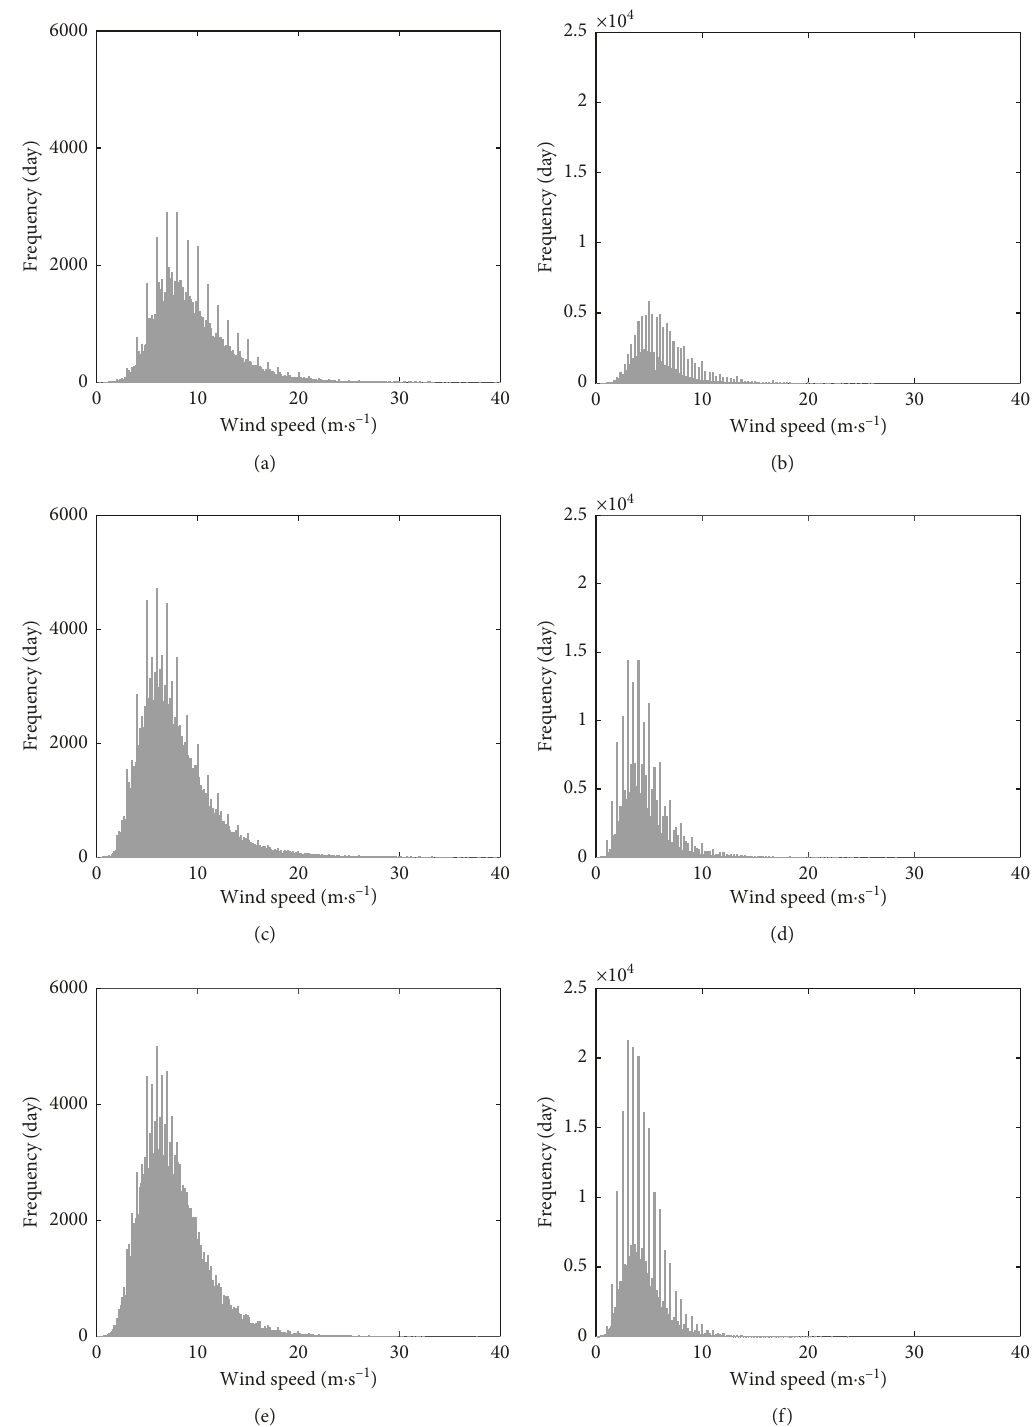
Figure 5: Daily maximum instantaneous wind speed (a, c, e) and daily maximum wind speed (b, d, f) frequencies in the metropolitan (top), central inland (middle), and south inland (bottom)